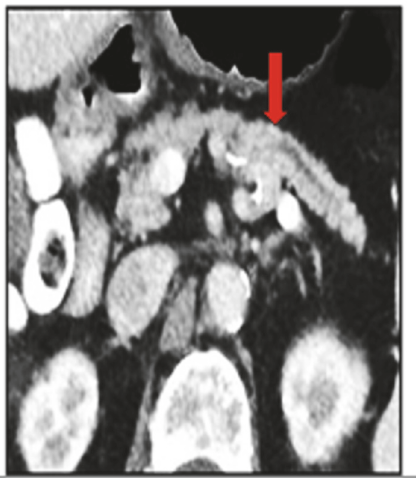
Figure 1: Axial abdominal CT-scan showing dilatation of the pancreas and duct cut-off sign (red arrow).